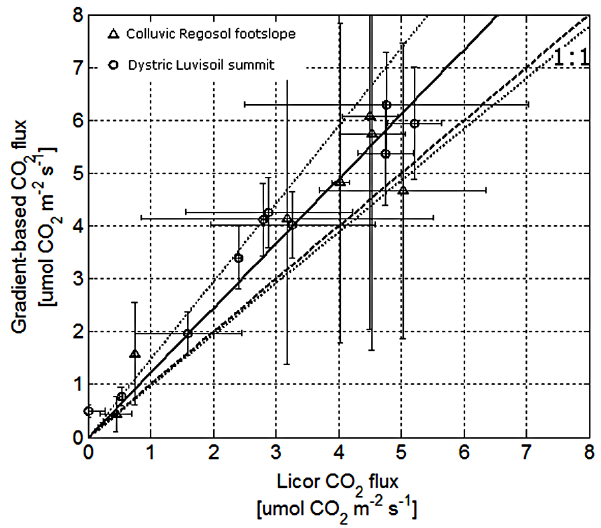
Figure 5. Agreement between soil surface CO 2 fluxes directly mea- sured with surface survey chambers (horizontal axes) and CO 2 fluxes calculated according to the gradient-based method (vertical axes) using the Moldrup et al. (2000) diffusivity model. The straight dashed line is the 1 : 1 ideal regression (perfect fit). The straight line is the fitted regression. The dotted straight lines represent a 25% relative error interval around the fitted